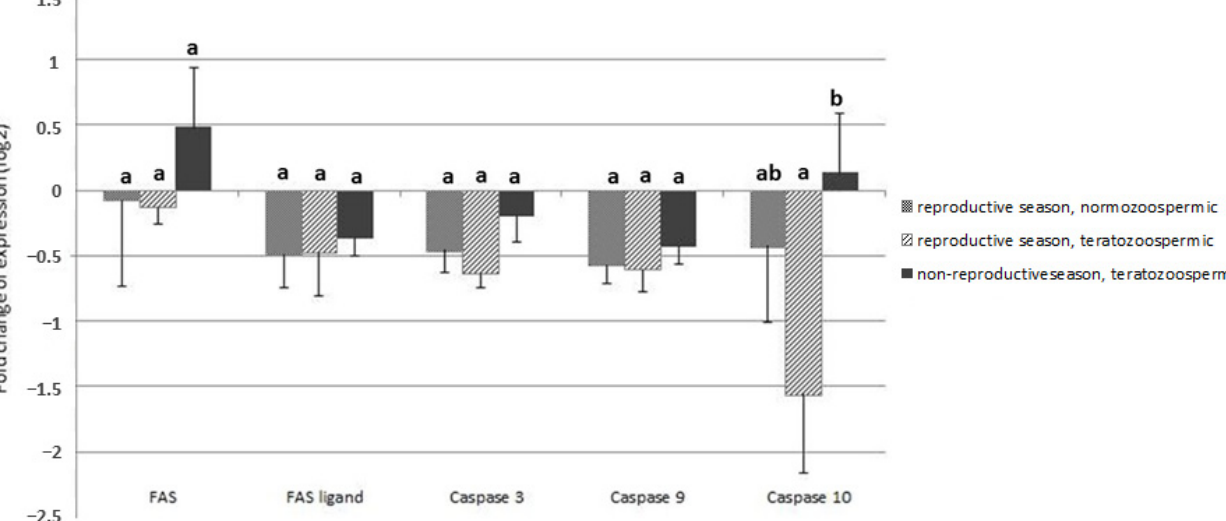
Figure 2. Results of Experiment I. Relative gene expression of antiapoptotic ( BCL2L1, BCL2 ) and proapoptotic ( BAX, BAD ) genes in testicular tissue collected during the reproductive and non-reproductive season. a, b: different lowercase letters indicate significant differences ( p < 0.05). Data presented as mean values ± SEM.